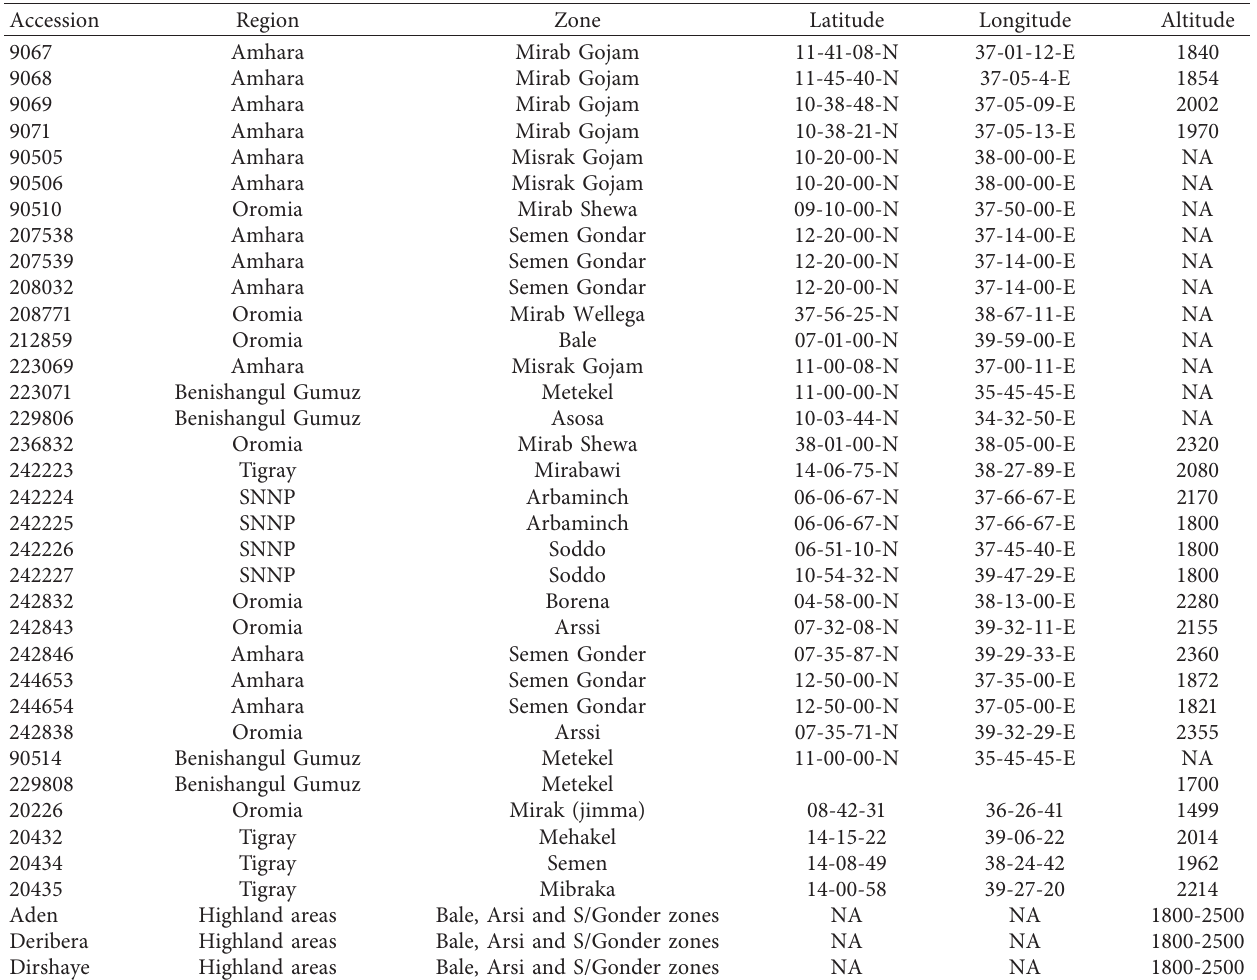
Table 1: List of the black cumin ( N. sativa ) accessions with their passport